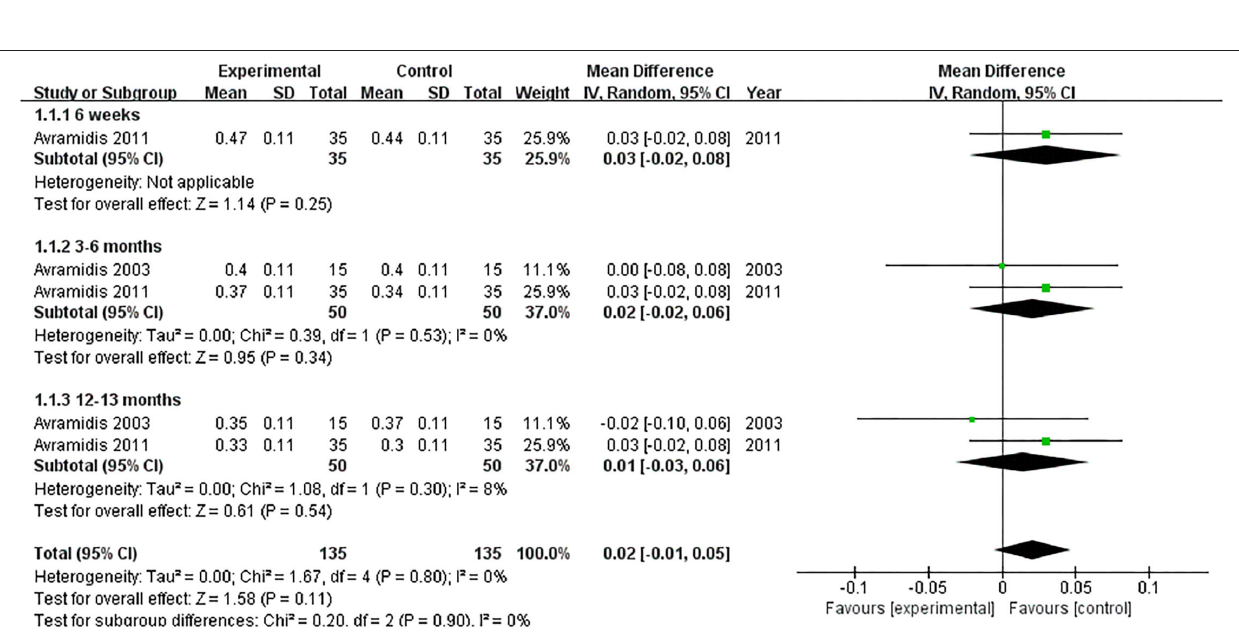
FIGURE 5 | Forest plots of meta-analysis of the effect of NMES vs. conventional rehabilitation on physiological cost index.